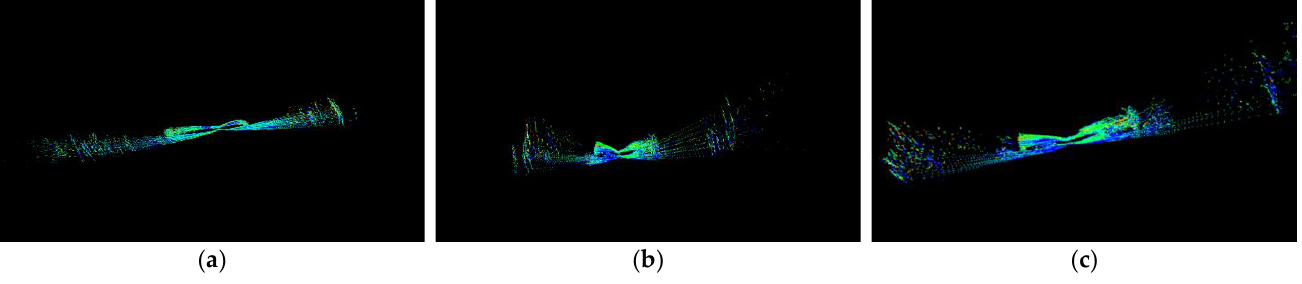
Figure 7. Point cloud image scene 3: President-Park-Outside-S16 ( a ) Picture 1, ( b ) Picture 2, ( c ) Pic- ture 3.